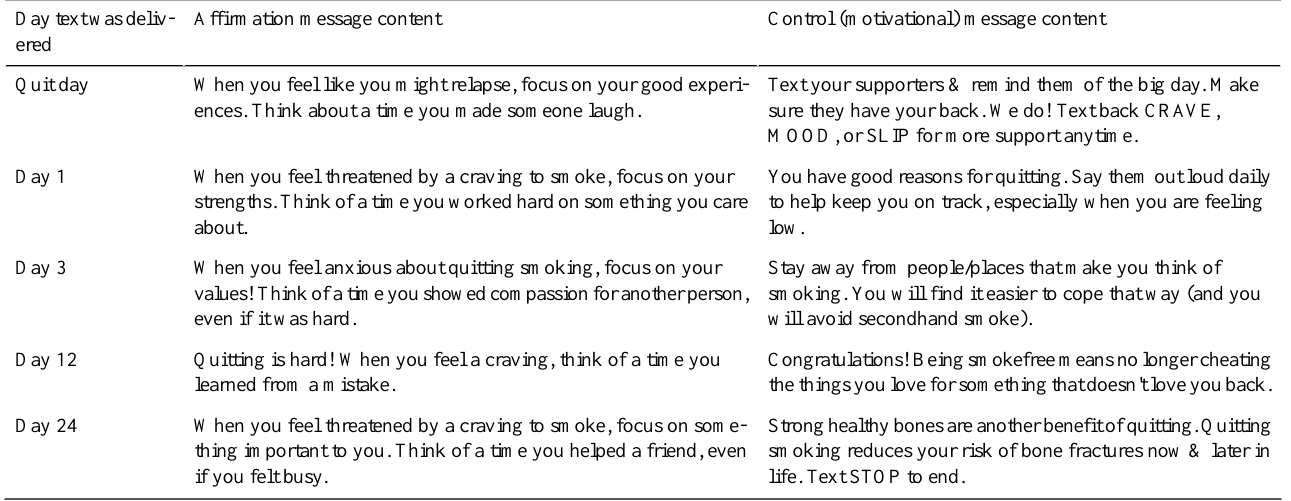
Table 1. Sample affirmation and control texts. ered